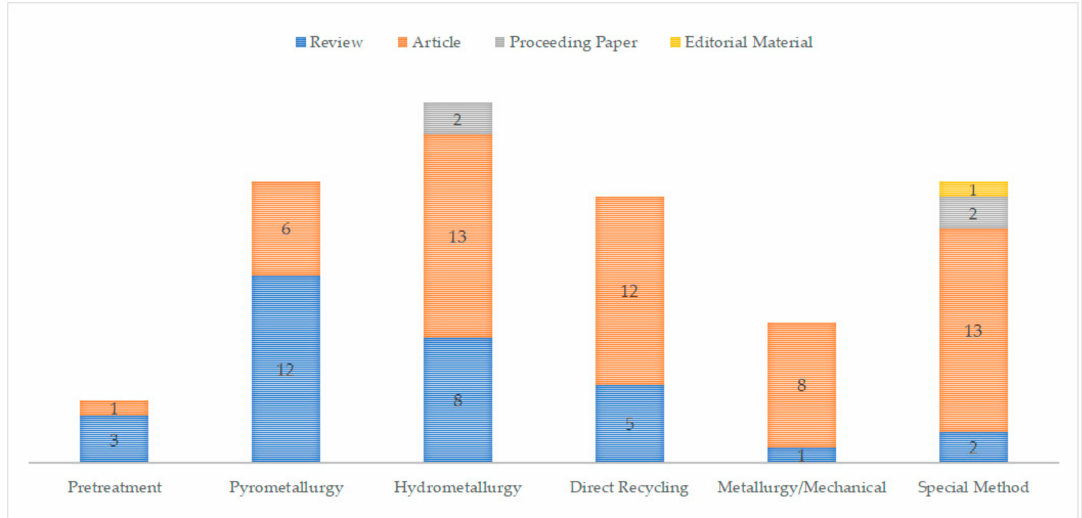
Figure 3. Distribution of “Recycling Technology” publications according to their